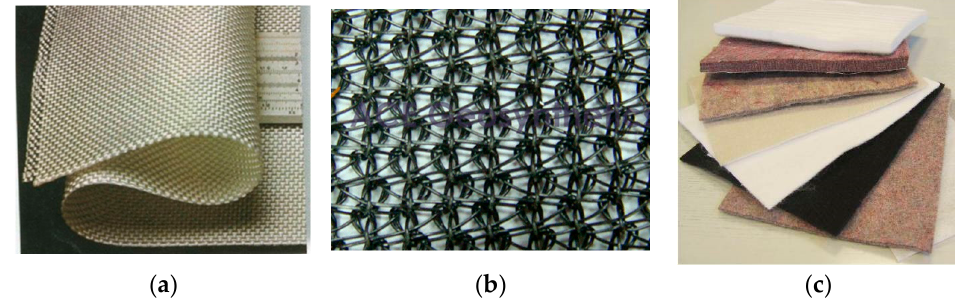
Figure 2. Examples of: ( a ) woven geotextile; ( b ) knitted geotextile; ( c ) nonwoven geotextile. Needle-punched nonwoven geotextiles are certainly the most important geotextiles to be installed, for example, in drainage systems. Needling is a process of bonding nonwoven web structures by mechanically interlocking the fibres through the web. Barbed needles, mounted on a board, punch fibres into the web and then are withdrawn, leaving the fibres entangled. The needles are spaced in a non-aligned arrangement and are designed to release the fibre as the needle board is withdrawn (Figure 3)